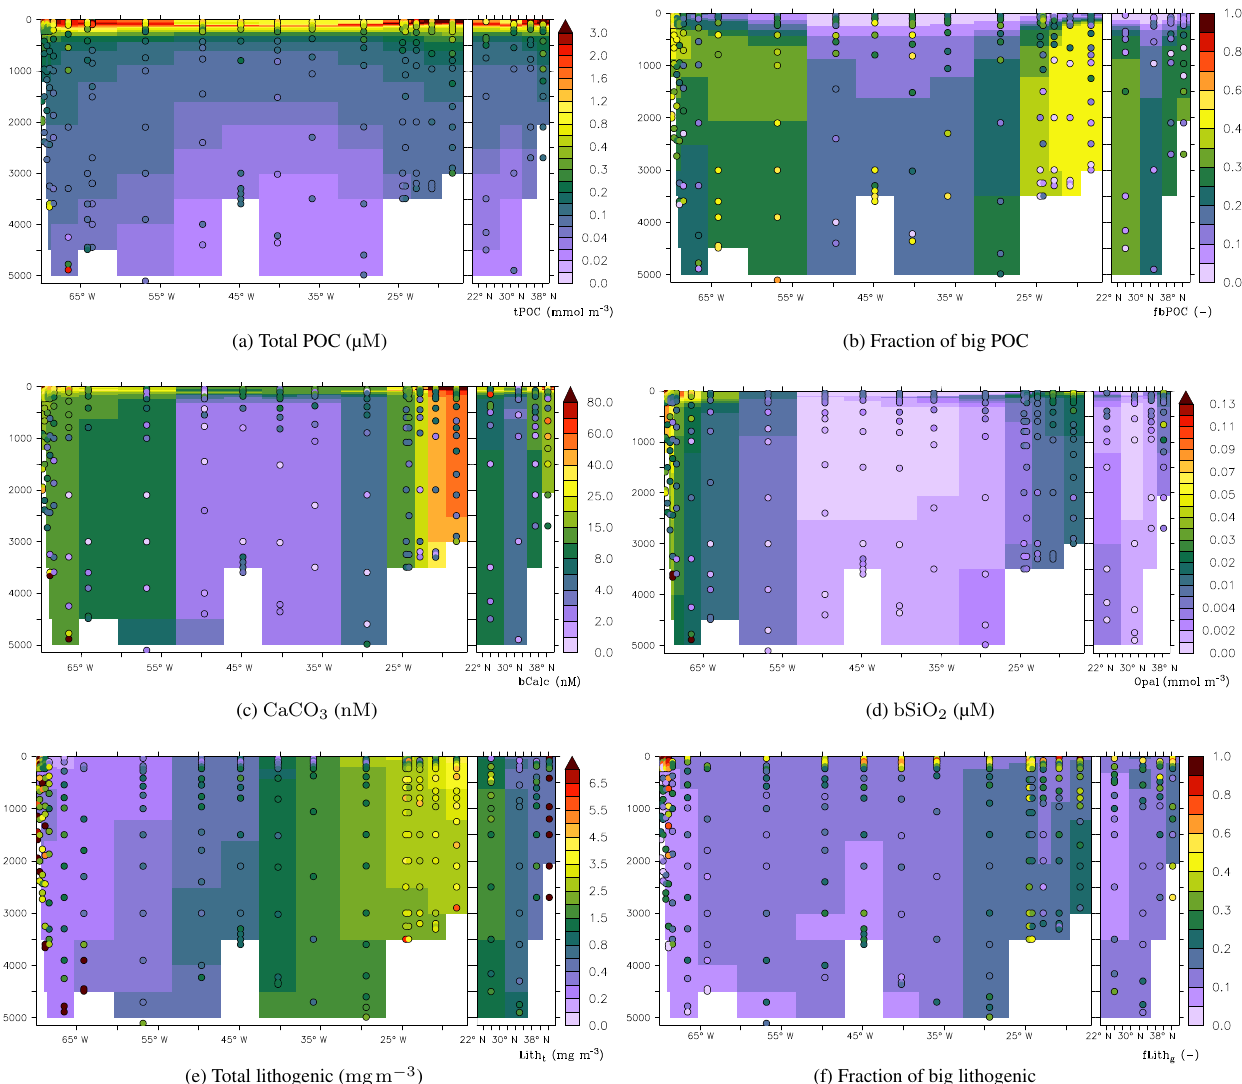
Figure 5. Particle fields at the GA03 North Atlantic GEOTRACES transect; observations (Lam et al., 2015) as coloured